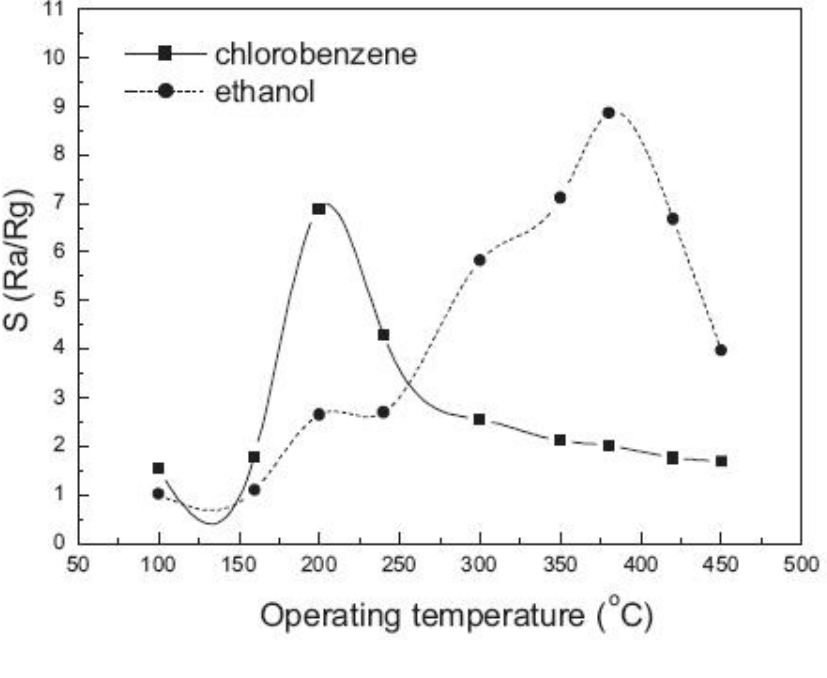
Figure 14. Gas response versus operating temperature of porous ZnO nanoplate sensor to 100 ppm chlorobenzene and ethanol (adapted from